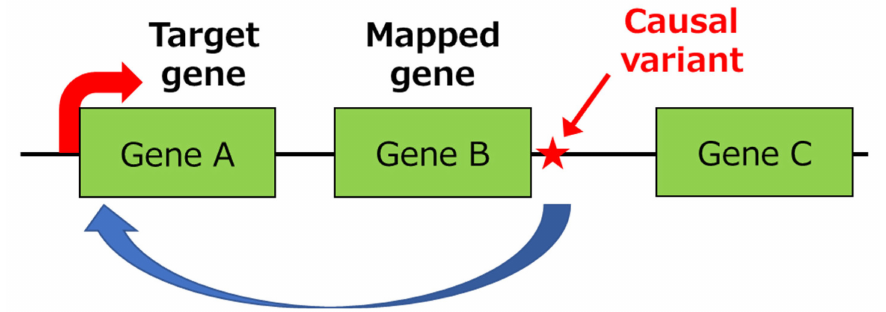
Figure 1. Example of the variant that regulates the expression of genes, separated from the primary functional variant by several hundred kilobases. As DNA adopts a higher-dimensional structure during transcription that associates with physically distant gene regions, primary functional variants often control the expression of other genes that are separated by several hundred kilobases (i.e., Gene A) from the mapped gene (i.e., Gene